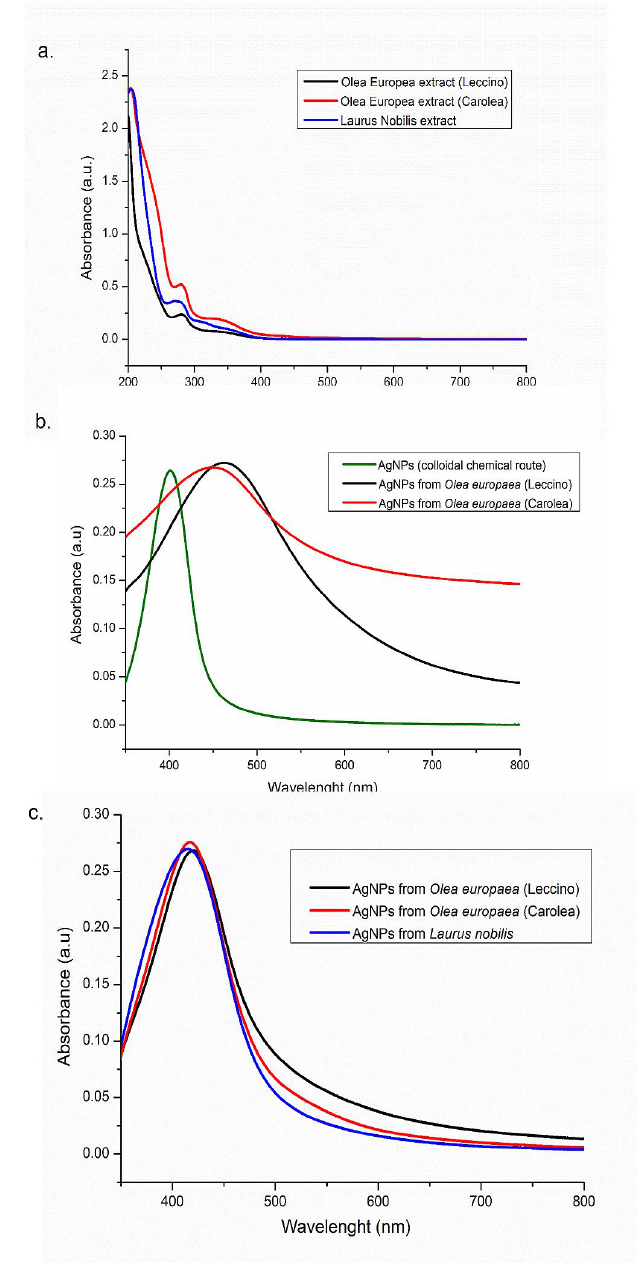
Figure 4. UV-vis spectra of Olea Europaea extracts ( Leccino , Carolea ) and Laurus Nobilis ( a ), UV-vis spactra of AgNPs derived from colloidal chemical routes and from green synthesis using Olea Europaea extracts ( Leccino and Carolea ) at pH 7 ( b ), AgNPs derived from green synthesis using Olea Europ aea extracts ( Leccino and Carolea ) and Laurus Nobilis at pH 8 ( c